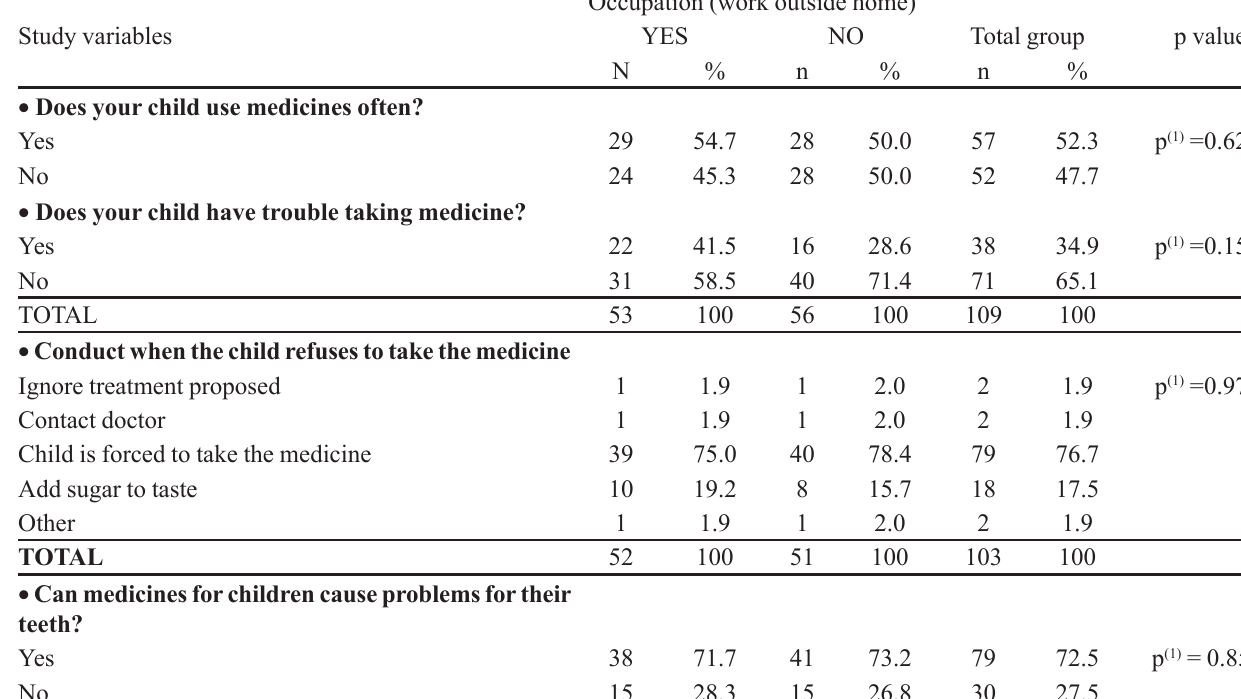
TABLE IV – Evaluation of issues on “Maternal Knowledge about Use of Pediatric Medicines”, by occupation of mothers interviewed Occupation (work outside home) Study